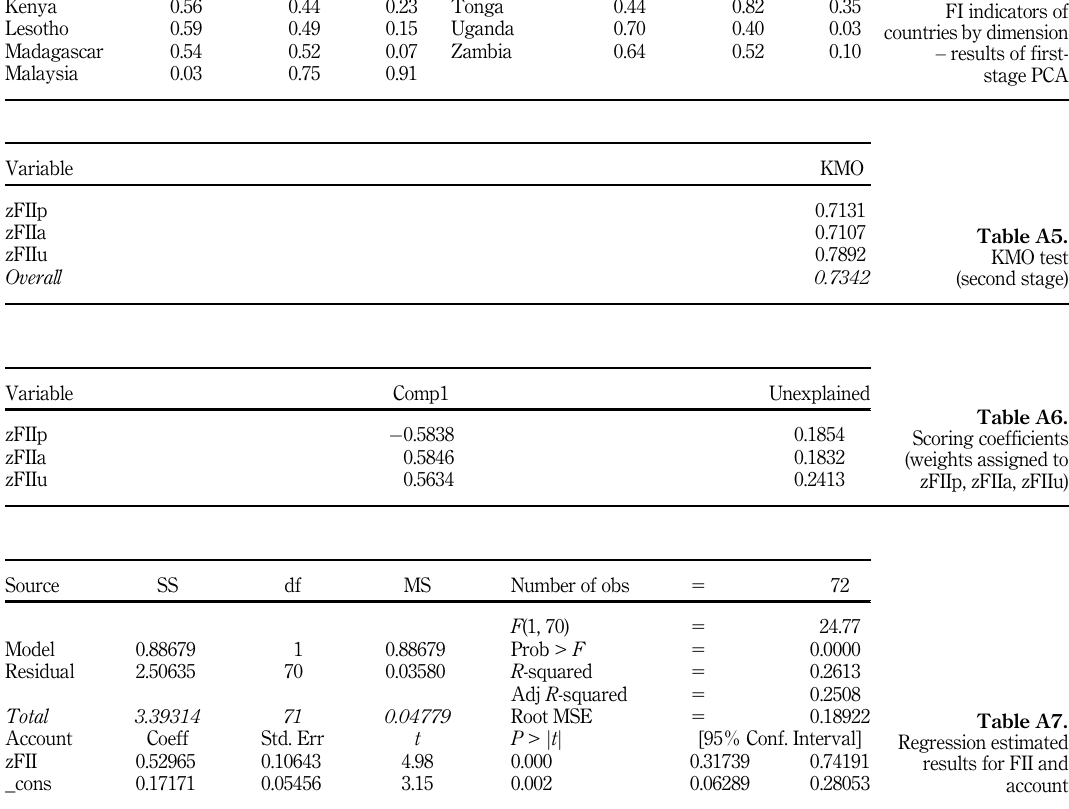
Table A4. FI indicators of